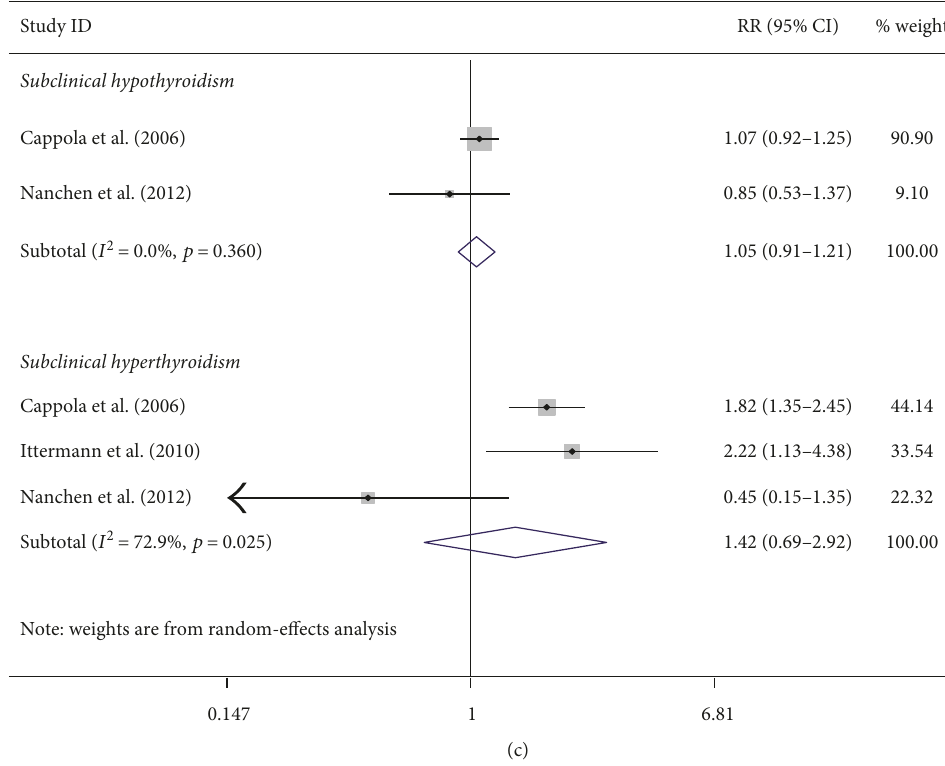
Figure 3: Forest plots for subclinical thyroid dysfunction. (a) Forest plots for subclinical thyroid dysfunction and CHD mortality; (b) forest plots for subclinical thyroid dysfunction and risk of heart failure; (c) forest plots for subclinical thyroid dysfunction and risk of atrial fi